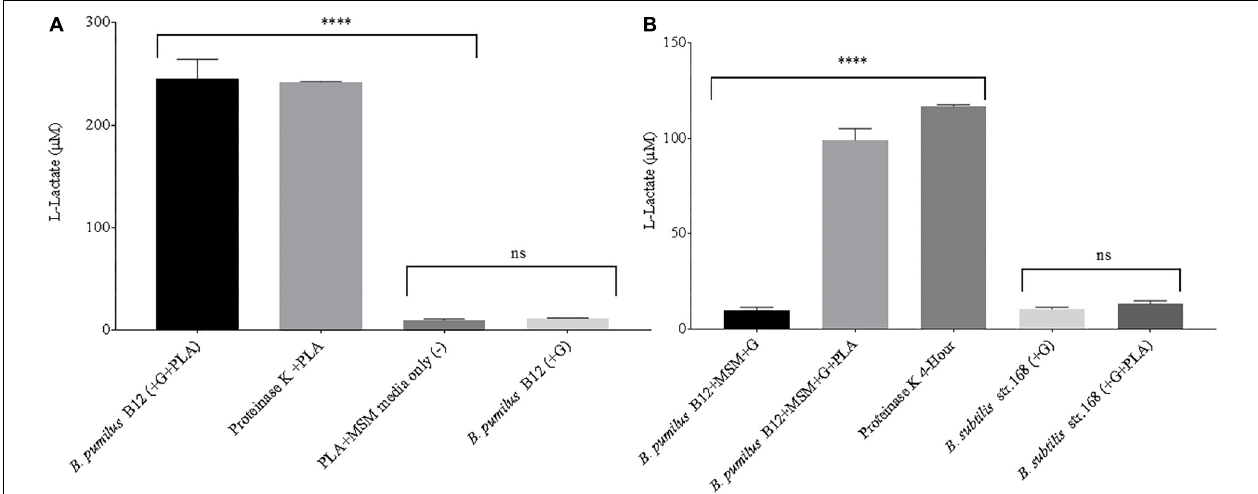
FIGURE 4 | (A) High levels of L-lactate can be detected in 3-week microbial cultures when both glucose and PLA are added. B. pumilus B12 was incubated for 3 weeks in minimal salt medium with PLA films and a primary carbon source of glucose was either absent (–) or present (+). Results were compared to PLA films incubated with Proteinase K for 4 h, and PLA incubated in MSM as a negative control. ∗∗∗∗ indicates ANOVA p -value ≤ 0.0001 and ns indicates ANOVA p -value ≥ 0.05 compared to PLA + MSM media only (–). These assays were performed with three biological and three technical replicates. (B) The addition of glucose significantly increases the release of L-lactate from PLA in microbial cultures. All microbial samples were incubated for 48 h in MSM supplemented with glucose (G). Supernatant samples that led to over saturation of the L-lactate detection assay were diluted 1:10 to ensure more accurate results. ∗∗∗∗ indicates ANOVA p -value ≤ 0.0001 compared to B. pumilus without PLA and ns indicates t -test p -value ≥ 0.05 comparing B. subtilis str.168 with and without PLA. These assays were performed with three biological and three technical replicates.